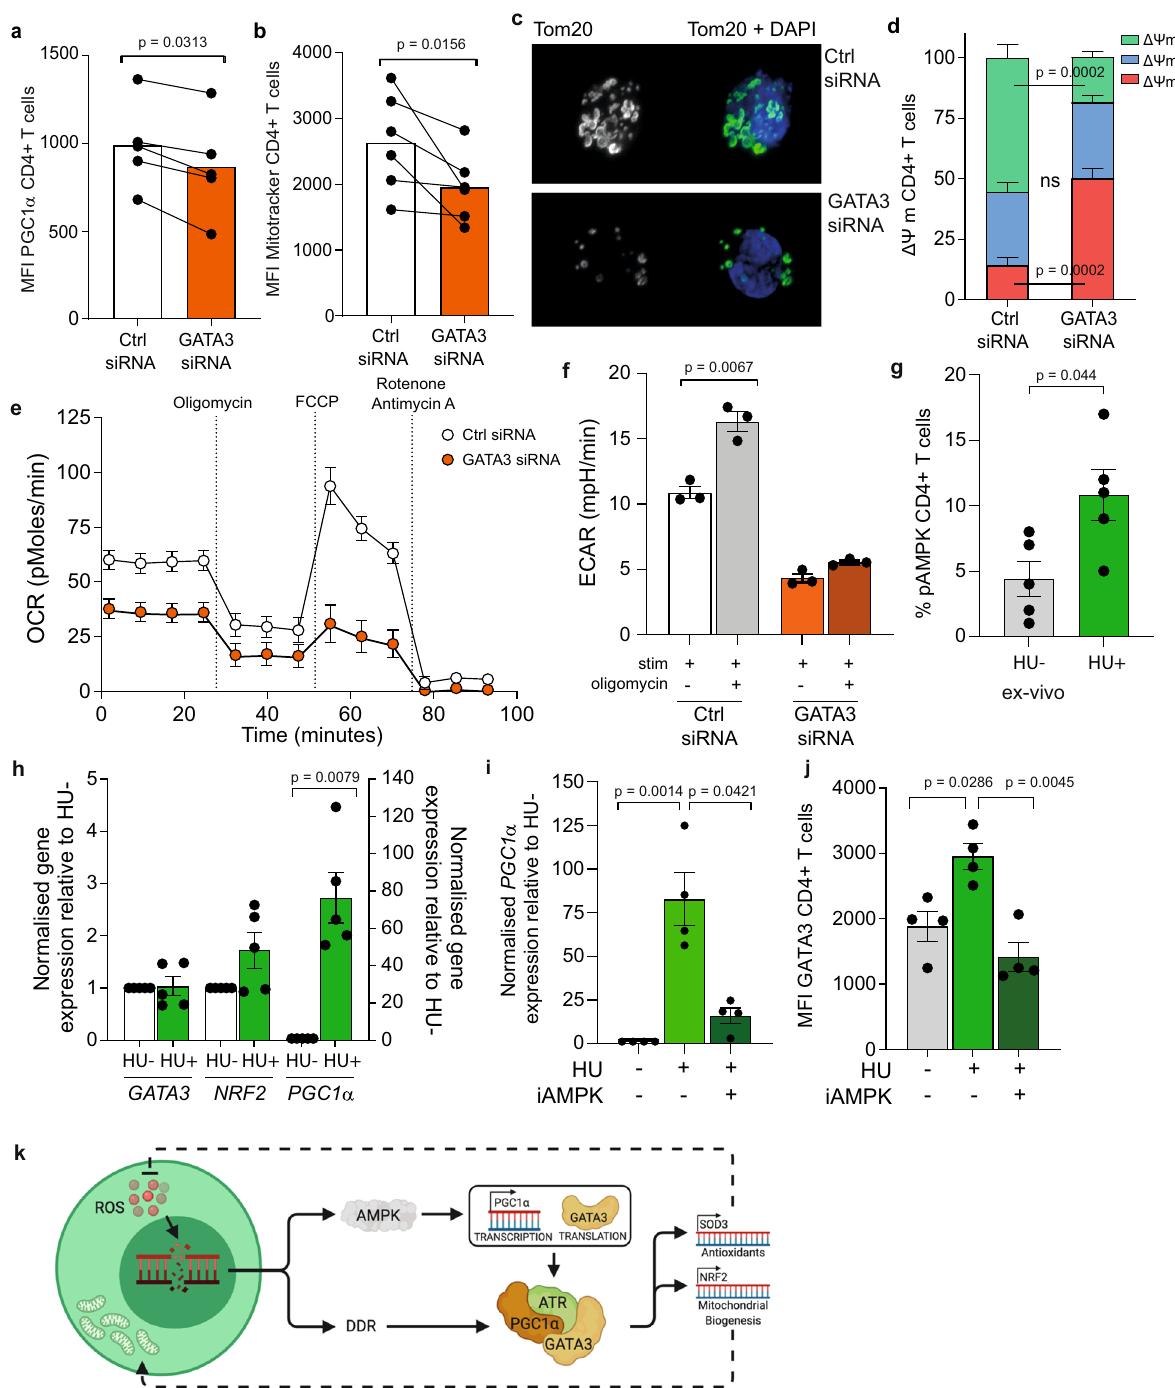
Compound C, an AMPK inhibitor, caused a signi fi cant loss of GATA3 protein in CD4 + T cells (Fig. 4j and Supplementary ment in this model. Despite chromatin immunocleavage showing